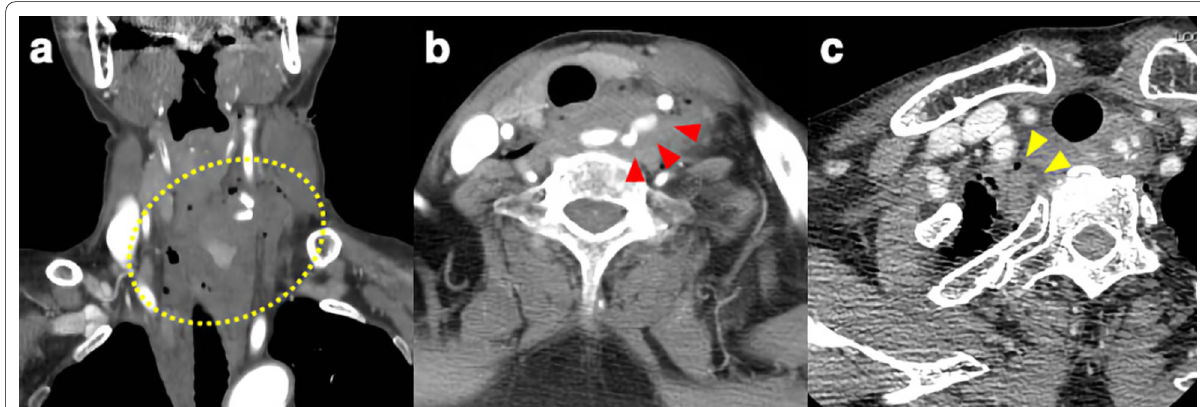
Fig. 1 CT at the time of transport to the hospital. a The hematoma was spread from the left neck to the right upper mediastinum (yellow dotted line). b The internal jugular vein was damaged, and extravascular leakage from the vein was observed (red arrowheads). c There was pulmonary contusion in the right upper lobe but no hemopneumothorax (yellow